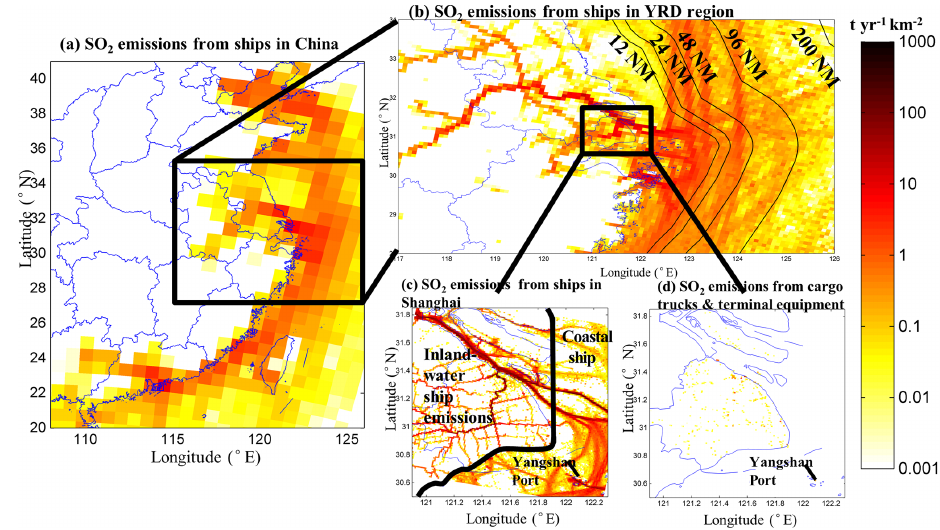
Figure 2. SO 2 emissions in 2015 from (a) shipping traffic in China (the average value of January and June) at a resolution of 81km × 81km; (b) ships in different offshore coastal areas (inland-water and within 12, 12–24, 24–48, 48–96 and 96–200NM of the coast) in the YRD region, at a resolution of 9km × 9km; (c) inland-water ships and coastal ships in Shanghai, at a resolution of 1km × 1km; and (d) cargo trucks and port terminal equipment in Shanghai, at a resolution of 1km × 1km. The black line in (c) refers to the division between the inland water and coastal water for the megacity of Shanghai defined in this study. Table 2. Primary emissions (tyr − 1 ), emission share of total shipping emissions (%) and emission density (tyrkm − 2 ) from shipping at different boundaries in the YRD region (domain 3) in